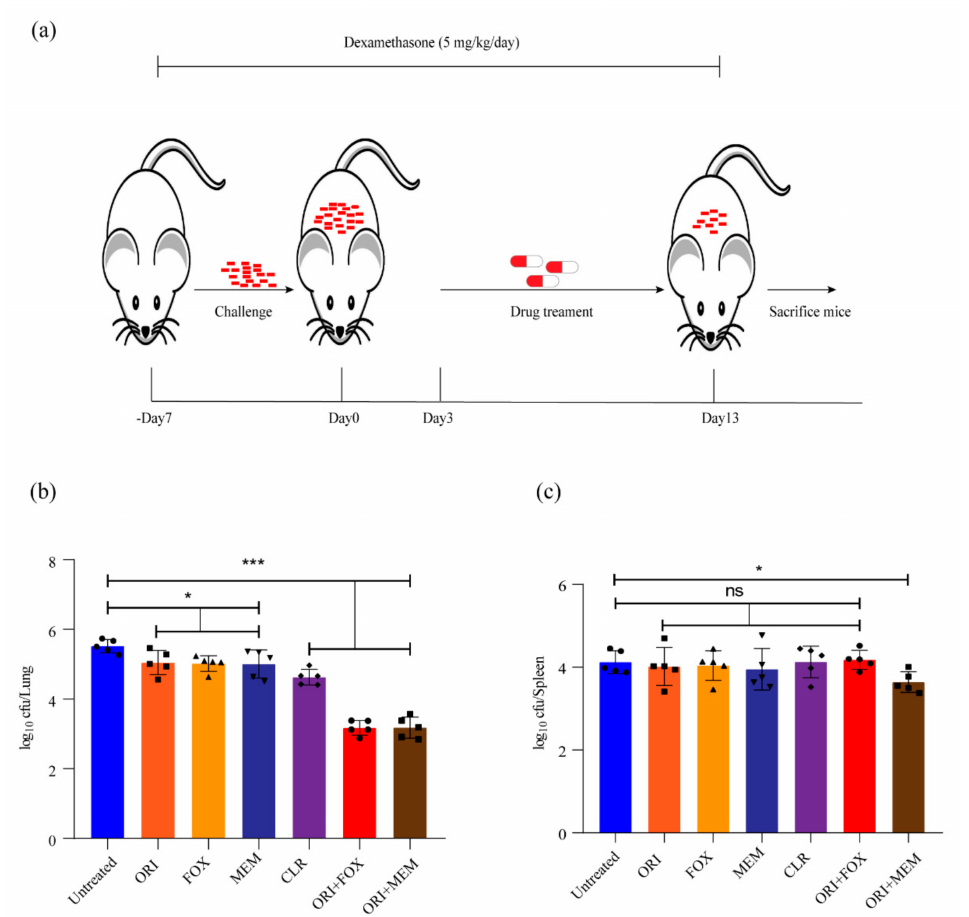
Figure 5. Evaluation of in vivo efficacy of oritavancin alone and its combination with cefoxitin or meropenem against M. abscessus in immunosuppressive mouse model. ( a ) Schematic diagram of mouse infection and drug treatment. –Day 7, 7 days before infection; Day 0, the day when challenge begins; Day 3, the day when infection ends and drug treatment starts; Day 13, the day when therapy ends and mice are sacrificed. The log10 cfu/mL indicates bacterial load in lungs ( b ) and spleen ( c ) of infected mice after treatment with 50 mg/kg oritavancin (ORI), 200 mg/kg cefoxitin (FOX), and 100 mg/kg meropenem (MEM) alone or in combination. The treatment with 100 mg/kg clarithromycin (CLR) serves as positive control. * p < 0.05, *** p < 0.001; ns, not